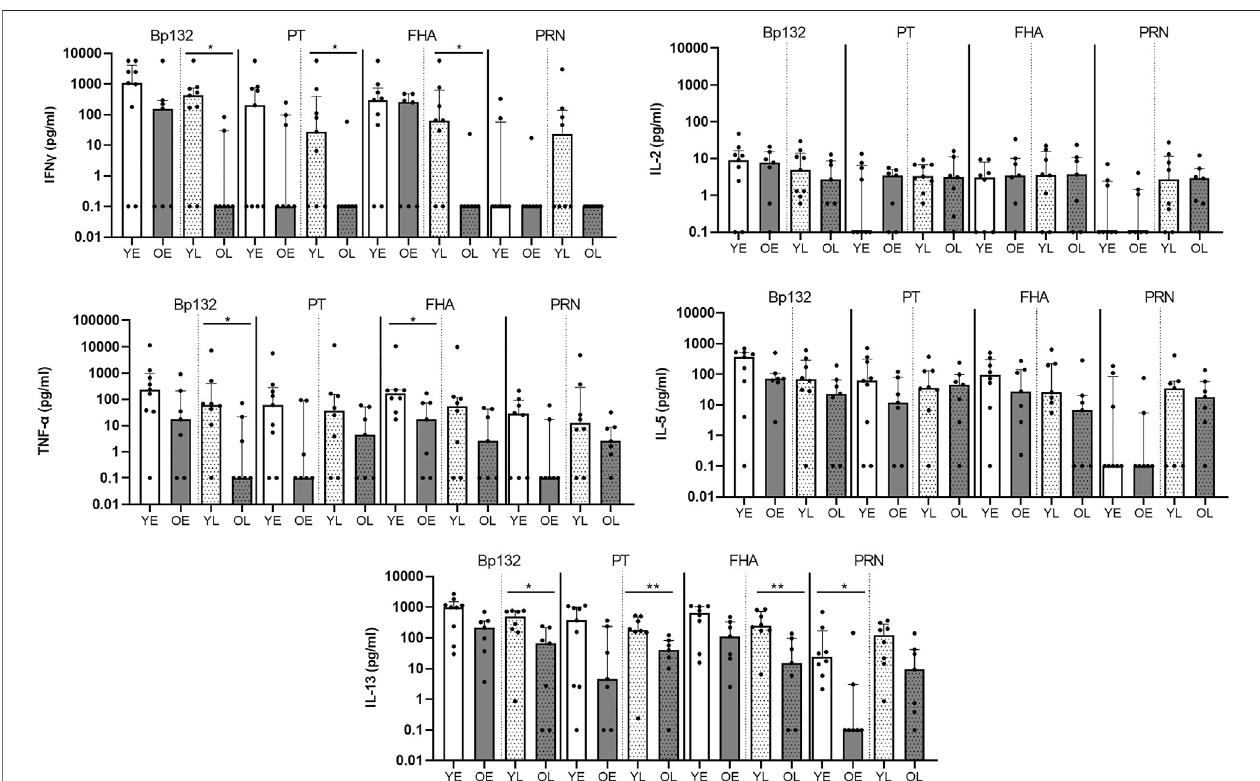
FIGURE3| Longitudinalfollowupofolderadultscon fi rmslowercytokineproductionafterBpinfection(Immfact).BargraphsshowtheconcentrationsofIL-2,TNF- α ,IL-5,andIL-13insupernatantsofPBMCs invitro stimulatedwithBppeptidepoolsBp132,PTS1(shownasPT),FHAandPRN,asindicated,inyoungsters( “ Y ” ,white bars) and older adults ( “ O ” , dark bars) in early ( “ E ” , open bars) and late ( “ L ” , dotted bars) phase after clinical diagnosis. Dots show individual cases while bars indicate medians and interquartile range. Statistical signi fi cance was calculated with Mann Whitney U -test. * p < 0.05.